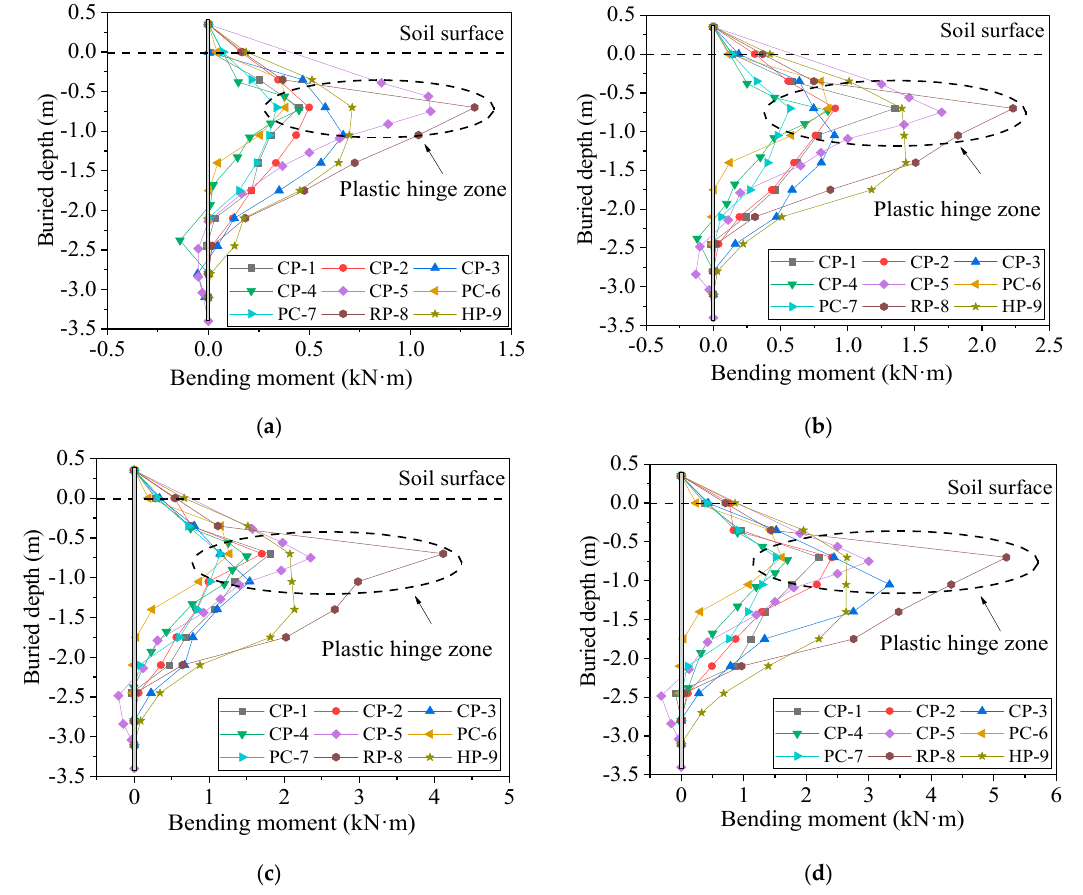
Figure 15. Bending moment of specimens. ( a ) At 2 mm loading step. ( b ) At 5 mm loading step. ( c ) At 8 mm loading step. ( d ) At 10 mm loading step. 8 mm loading step. ( d ) At 10 mm loading